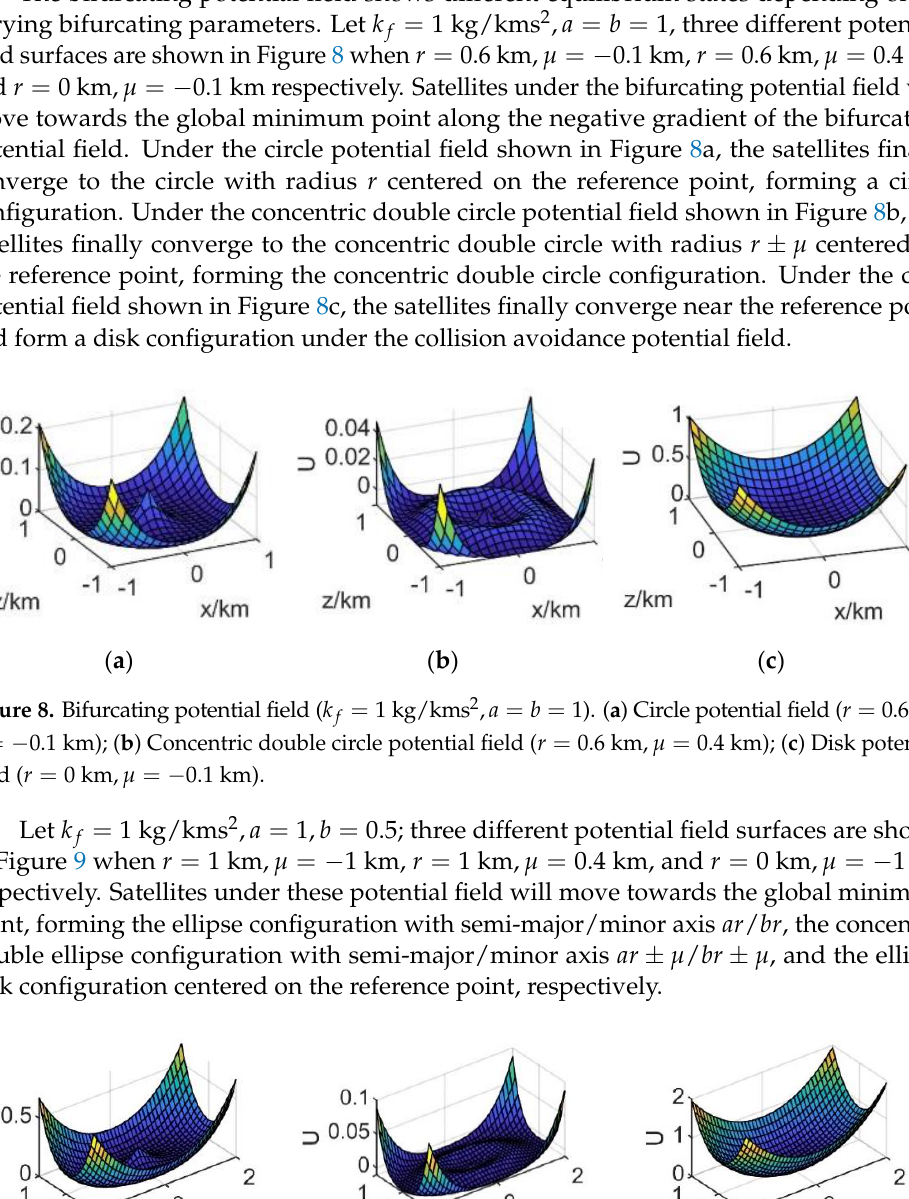
varying bifurcating parameters. Let The bifurcating potential field shows different equilibrium states depending on its